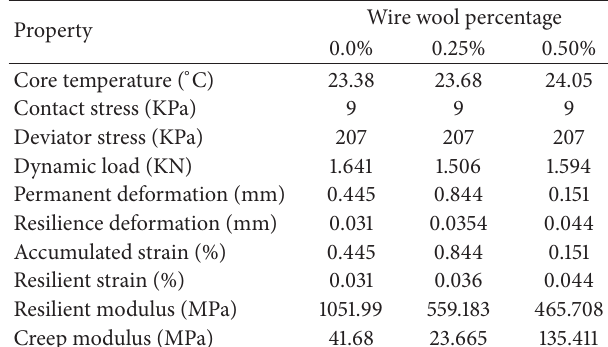
Table 5: Effect of adding wire wool on the creep properties of the